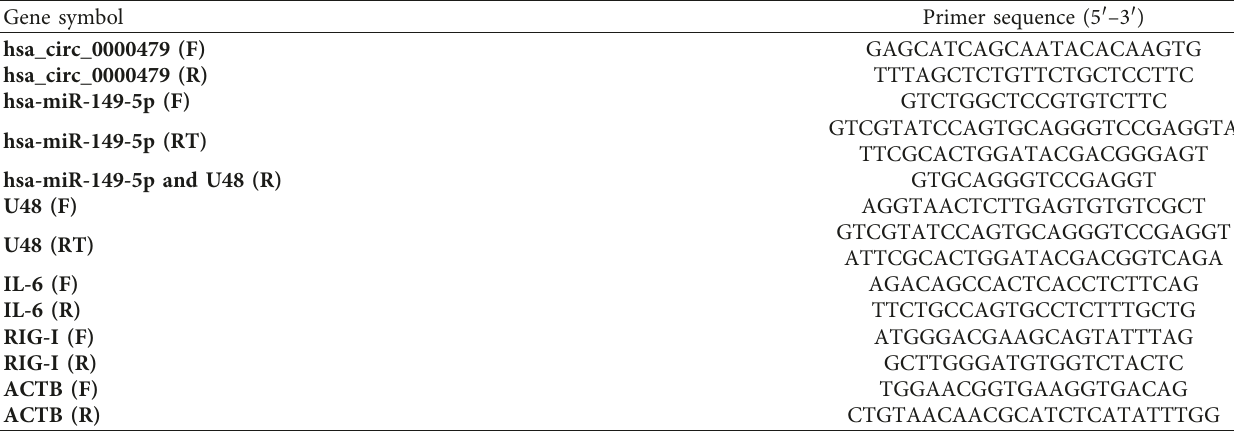
Table 1: qRT-PCR primers sequences.